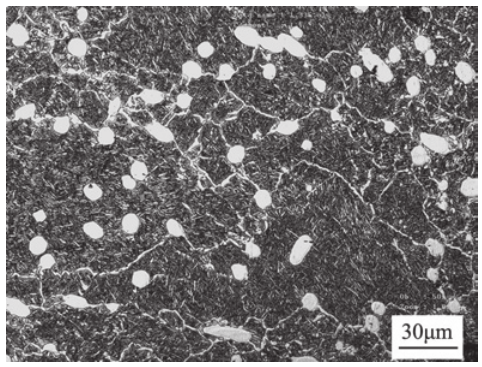
Fig. 1: Microstructure of Ti 3 Al-based